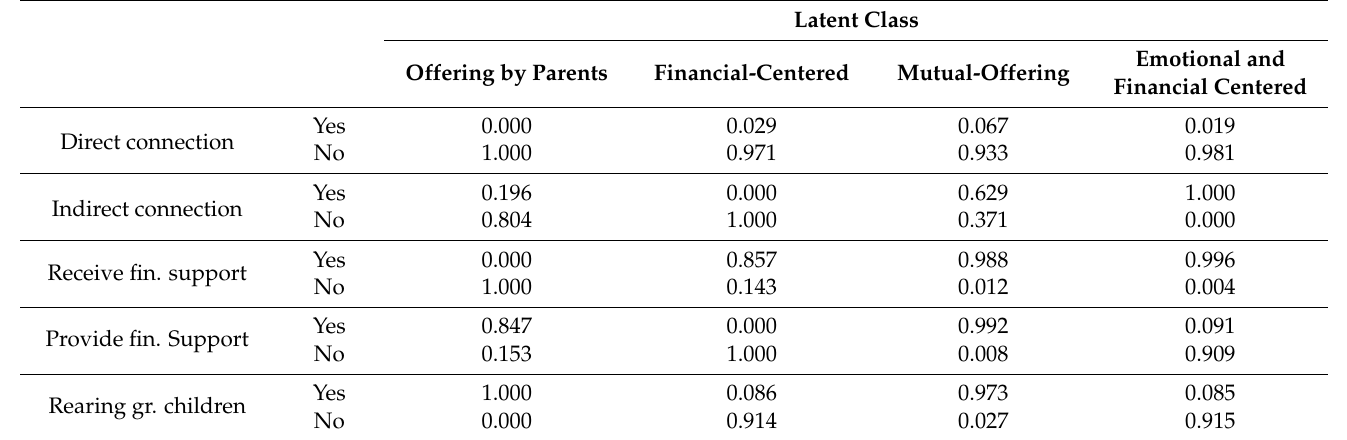
Table 2. Components of each class and naming.